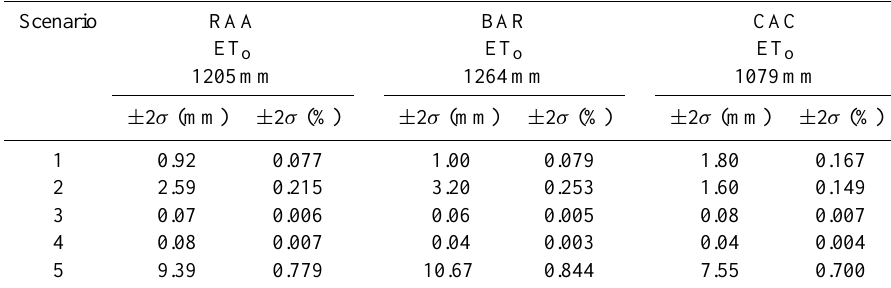
Table 4. Values of average annual ET o (mm) during the period 2004–2011 with their associated error value ( ± 2 σ ) according to different scenarios (Table 3). Irrigation districts of Riegos del Alto Arag´on (RAA, Gra˜n´en weather station), Canal de Bardenas (BAR, Ejea weather station) and Canal de Arag´on y Catalu˜na (CAC, Tamarite weather station).